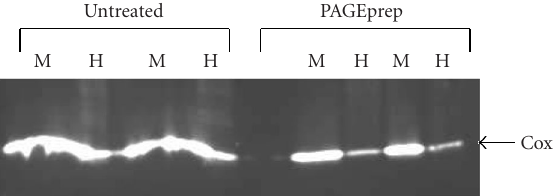
Figure 3. Removal of detergent from cell lysis fractions by the PAGEprep resin. Rat C6 cells were lysed and a membrane pro- tein fraction isolated using the Mem-PER reagents. Membrane (M) and hydrophilic (H) cell fractions were separated by SDS- PAGE (4–20% gradient gel) with or without prior treatment us- ing PAGEprep resin to remove detergent. Western blot analysis was performed as described in materials and methods using an antibody against Cox4. PAGEprep-treated samples show better band resolution than samples that were untreated and still con- tained the detergent.